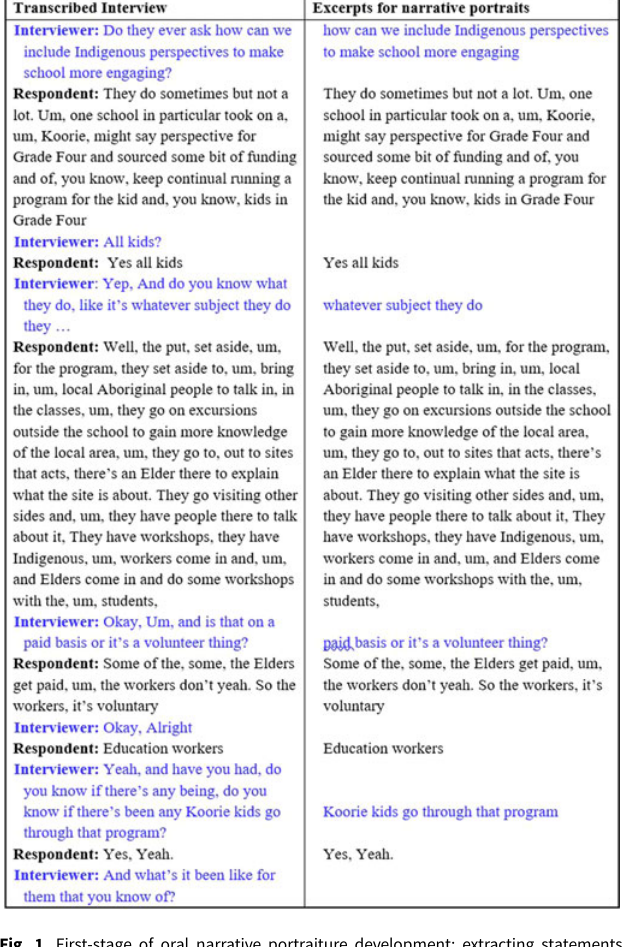
Fig. 1. First-stage of oral narrative portraiture development: extracting statements from interview transcripts.